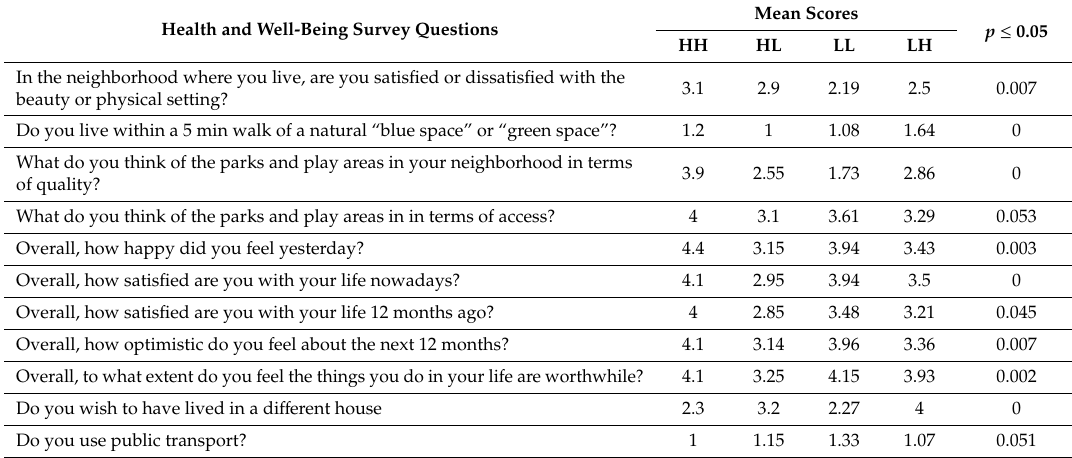
Table 1. Mean scores and p value of the variables in the analyses.